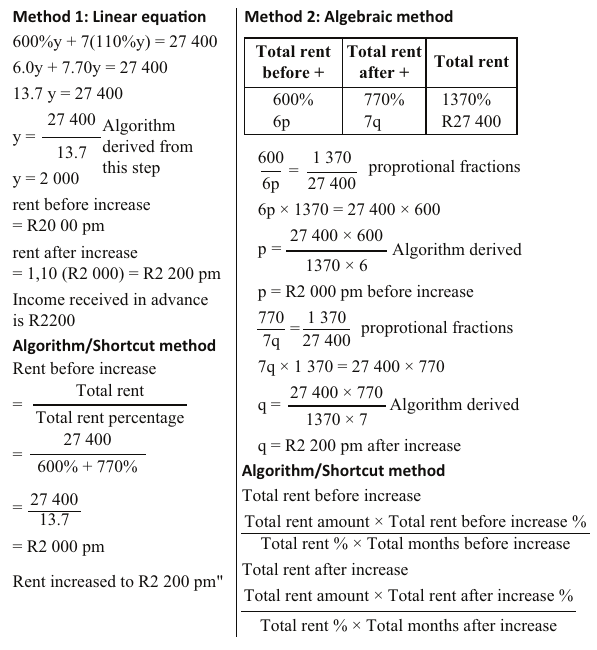
FIGURE 16: Rent calculation, given increase in